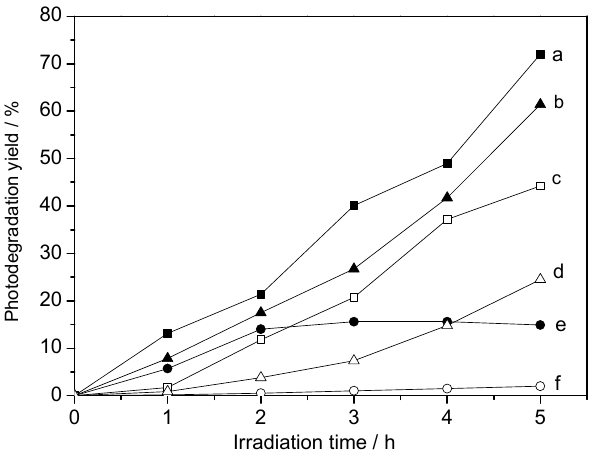
Figure 7. Photocatalytic degradation curves of GV, under solar light irradiation, for (a) R-TiO 2 /SiO 2 ; (b) WH-TiO 2 /SiO 2 ; (c) P25; (d) TiO 2 -p; (e) D-TiO 2 /SiO 2 ; and (f) no catalysts.